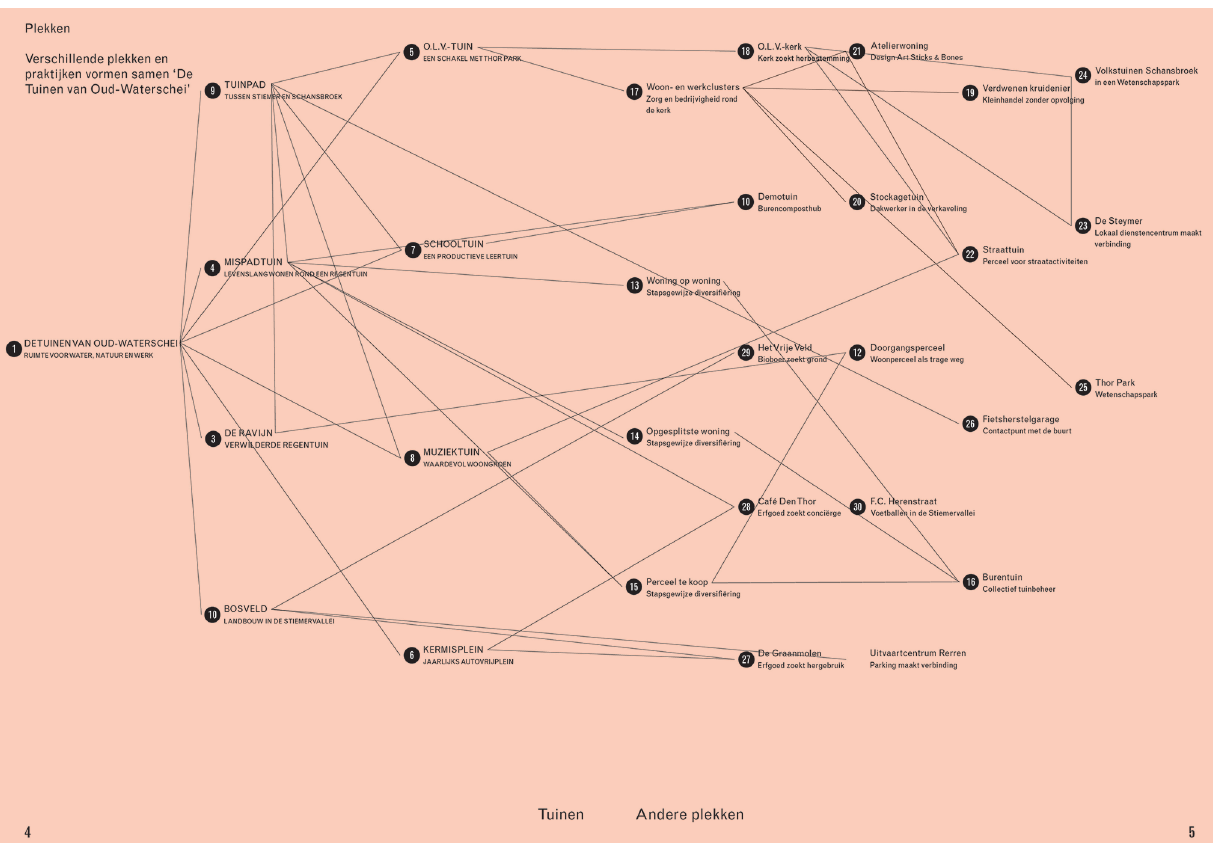
Figure 6. Scheme of relationships between different neighbourhood places in the first section ‘places’ of the atlas. Source: Barbara